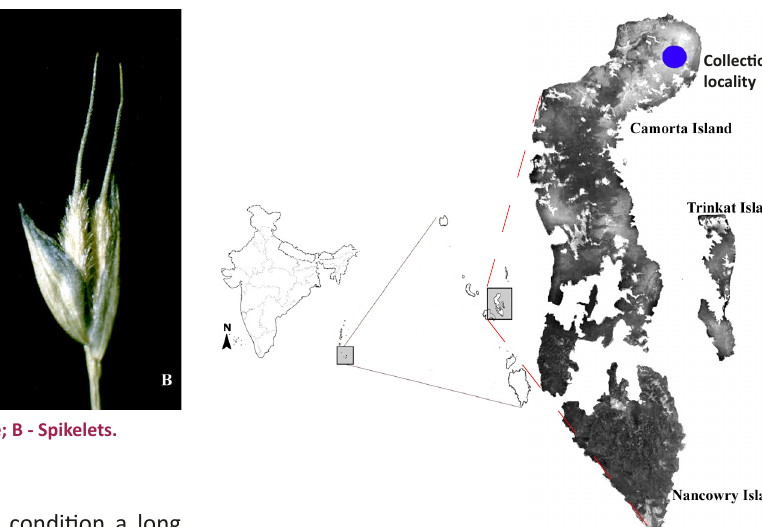
Figure 1. Distribution map of Aira caryophyllea in Nicobar